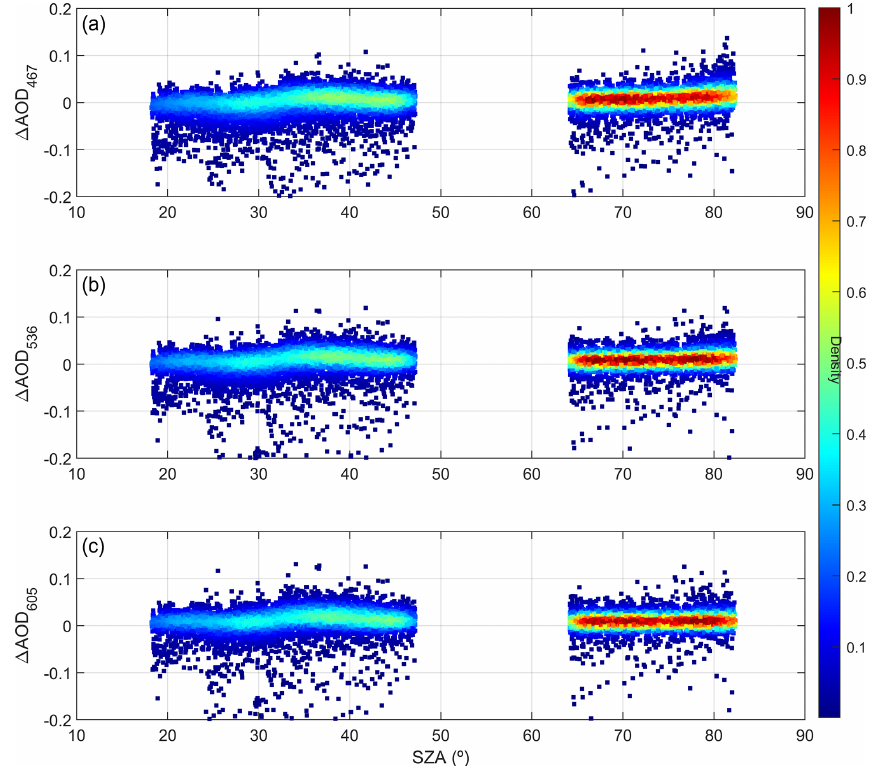
Figure 11. The (cid:49) differences in the aerosol optical depth (AOD) retrieved by GRASP with the single-pixel approach (GRASP-CAM) and those obtained by AERONET at 467nm (a) , 536nm (b) and 605nm (c) as a function of the solar zenith angle (SZA). The colour legend represents the density of data